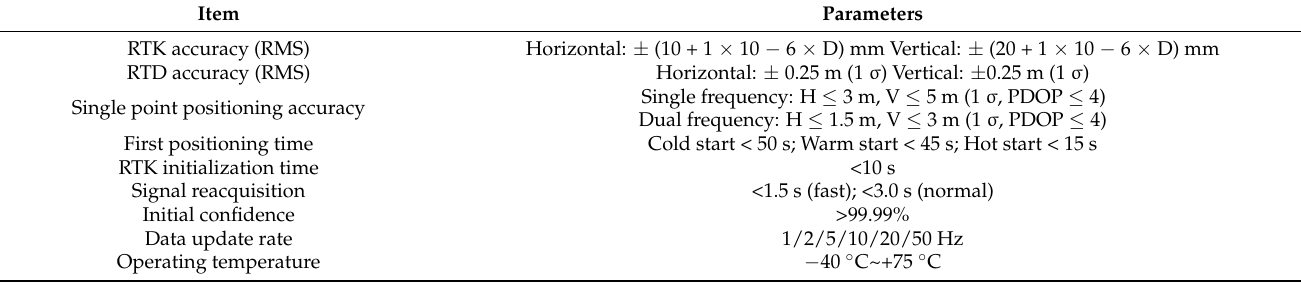
Table 2. Parameters of M100 receiver.